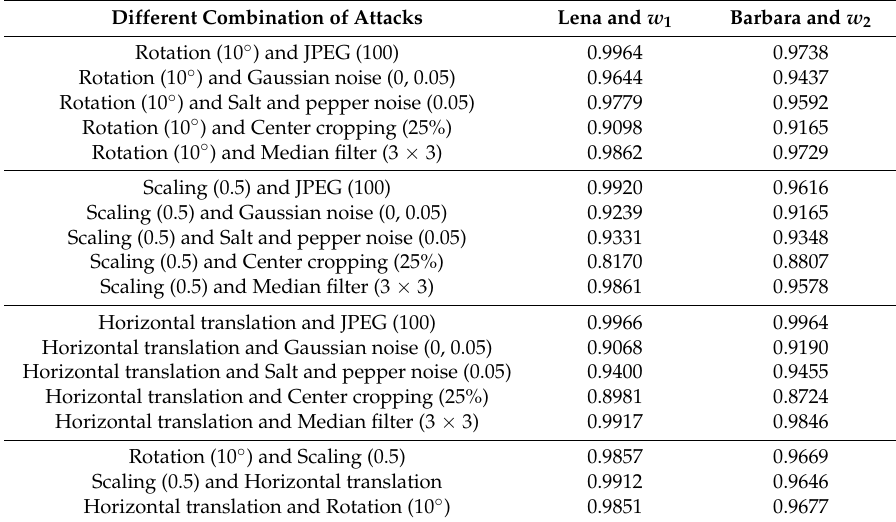
Table 3. Robustness performance on different combination of attacks.